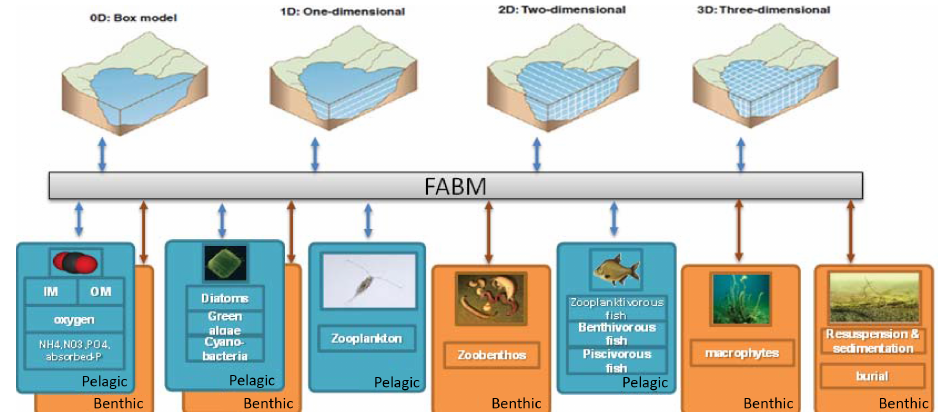
Figure 2. The modular structure of the FABM-PCLake code. Each square box represents a FORTRAN module of FABM-PCLake (and these modules interact/communicate through FABM to simulate the processes illustrated by arrows in Fig. 1). The brown colored boxes are related to the sediment domain and the blue boxes to the water column domain. Note that all modules may be applied for zero-dimensional to three-dimensional spatial domains. A detailed description of the contents of each module is provided in the